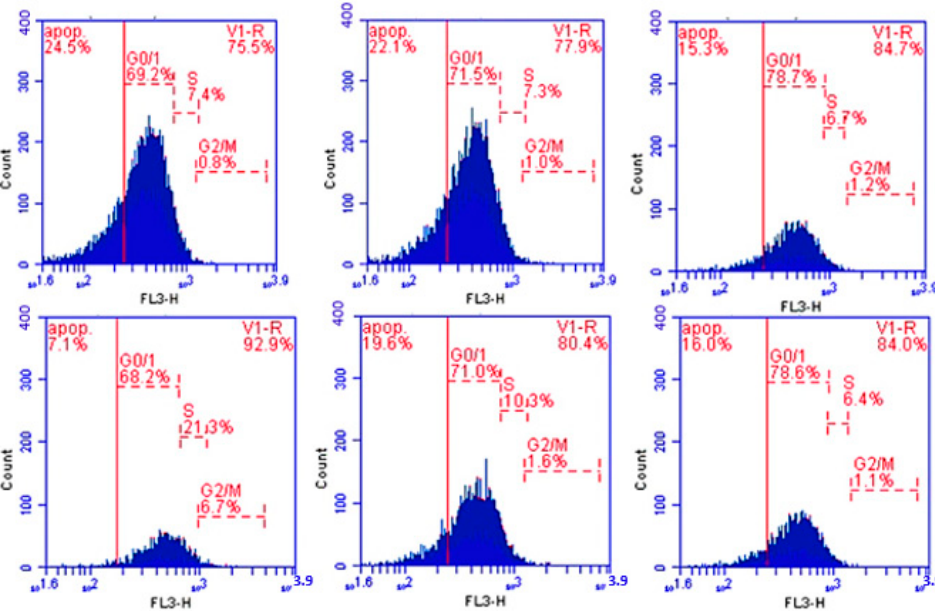
Figure 4. Histograms showing percentage (%) of cells in G0/1, S, and G2/M phases in differ- ent groups.